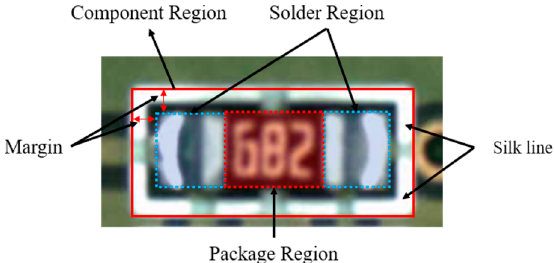
Figure 7. Solder region of the chip component. The area marked with a blue square is the solder region, and the area, marked with a red square is the package region. The white area around the solder and package region is the silk line.